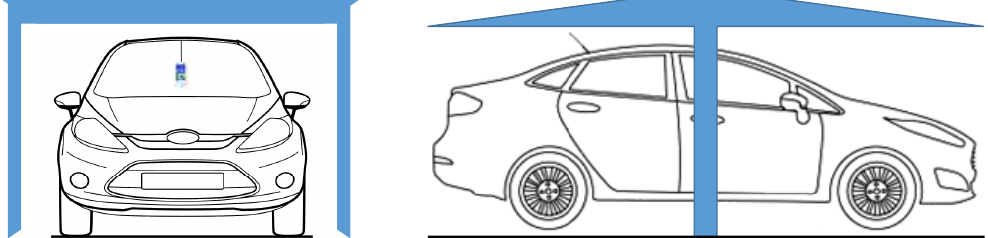
Figure 9. Condition 3, car is shaded under open type